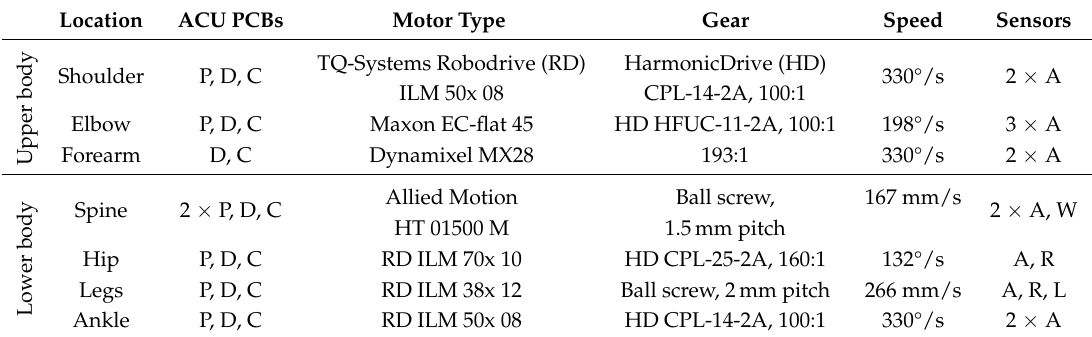
Table 2. Configurations of the Actuator Control Units (ACU), motors, gears, speed and sensors. Each ACU consists of zero or more PCBs for P ower electronics, D ata acquisition and communication, or C omputation. To control a motor, it senses the motor position via iC-MU [48] A bsolute encoders or R elative encoders (Hall sensors). In addition, L inear potentiometers (WayCon) or draw W ire sensors (WayCon) are used for linear drives to sense the